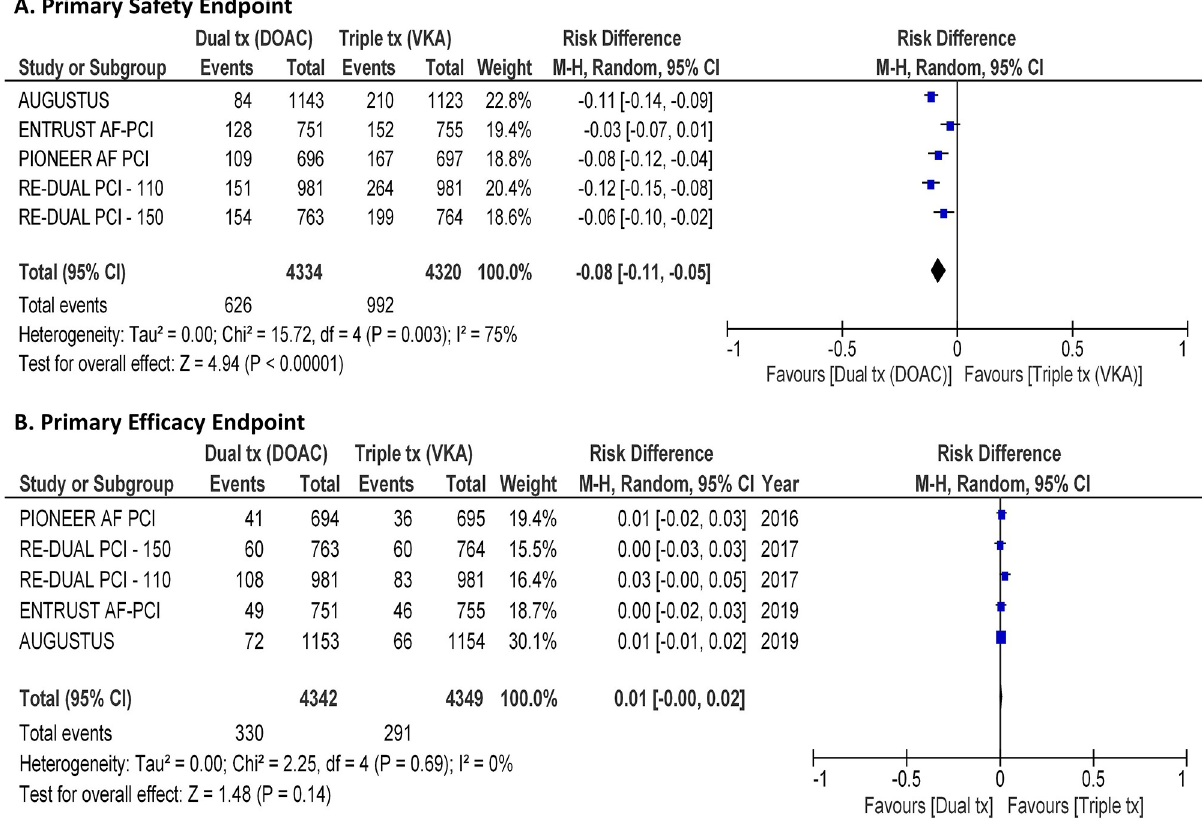
Fig 2. Primary endpoints. Forest plots illustrating the results of meta-analysis on the primary safety endpoint ( panel A ), and the primary efficacy point ( panel B ). 95% C.I. = 95% confidence interval; DOAC = direct oral anticoagulants; VKA = vitamin K antagonist; I 2 = Inconsistency index.